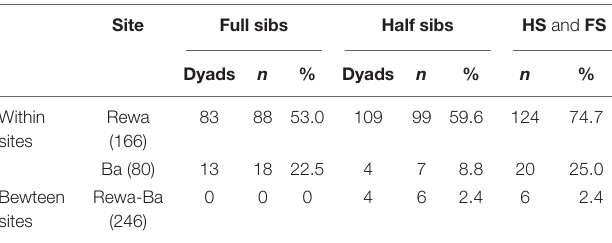
TABLE 1 | Numbers of full sibling (FS) and half sibling (HS) dyads and numbers of individuals (n) represented in each of the related categories for each of the sites and related dyads identified between sites.